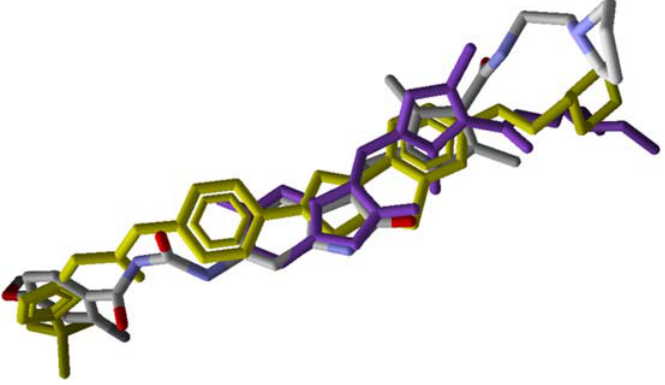
Figure 5. Overlapped conformations of compound 1 , Quizartinib (yellow), and Sunitinib (purple).